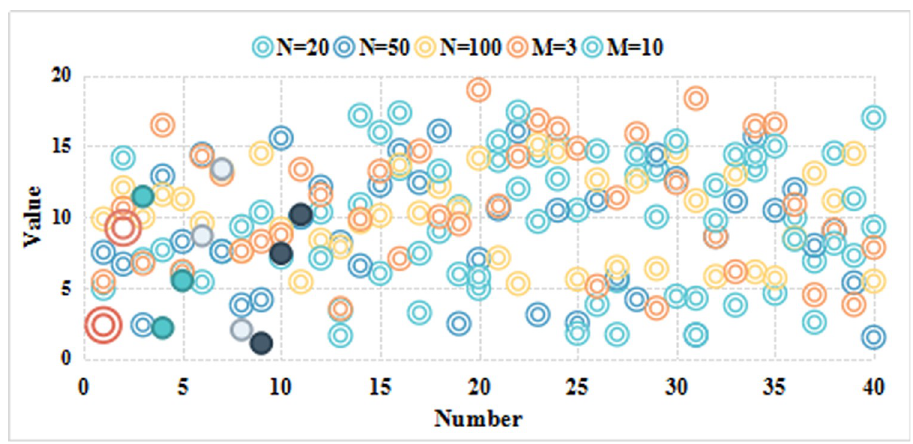
Fig 7. The comprehensive ability